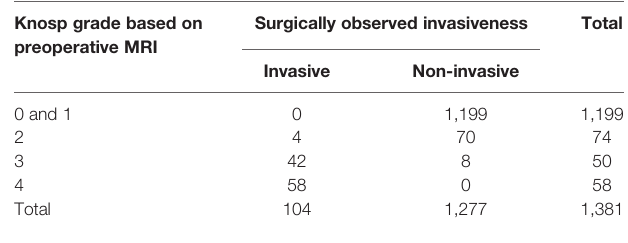
TABLE 2 | Comparison of results of Knosp grade based on preoperative MRI and surgically observed cavernous sinus invasion. Knosp grade based on preoperative